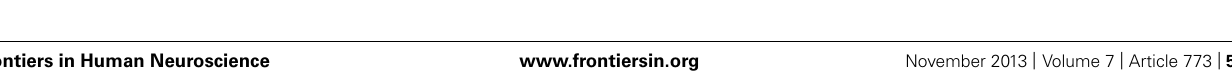
Frontiers in Human